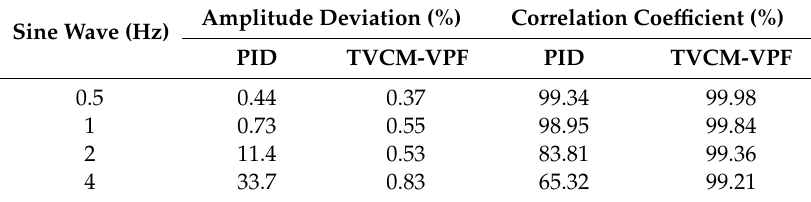
Figure 7. Experimental results of the sine wave target test. Table 2. Error comparison of the sine wave excitation